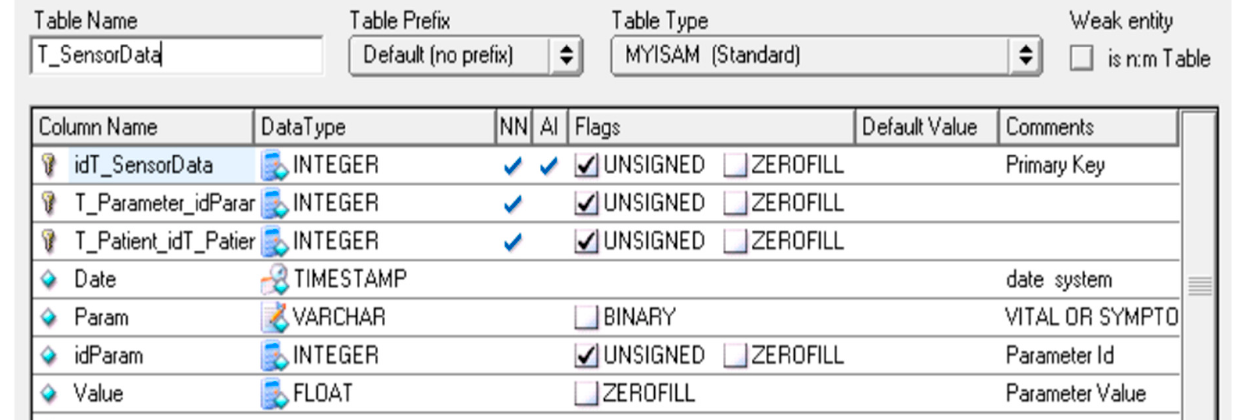
Figure 3. Main components of the data conceptual model. 3. Architecture for COVID-19 Suspected Detection in the Context of Monitoring COPD Patient s 3.1. System Architecture As shown in Figure 4, the architecture of our proposal is composed of four layers: the data acquisition layer, representation layer, processing layer, and application layer. Figure 4 also describes the mechanism related to detecting suspected COVID-19 cases among COPD patients. Sensors installed on COPD patients collect information on vital sign parameters from the patient context. Then, the dynamic data is stored in a dynamic database. Data collected from patients represent context information.